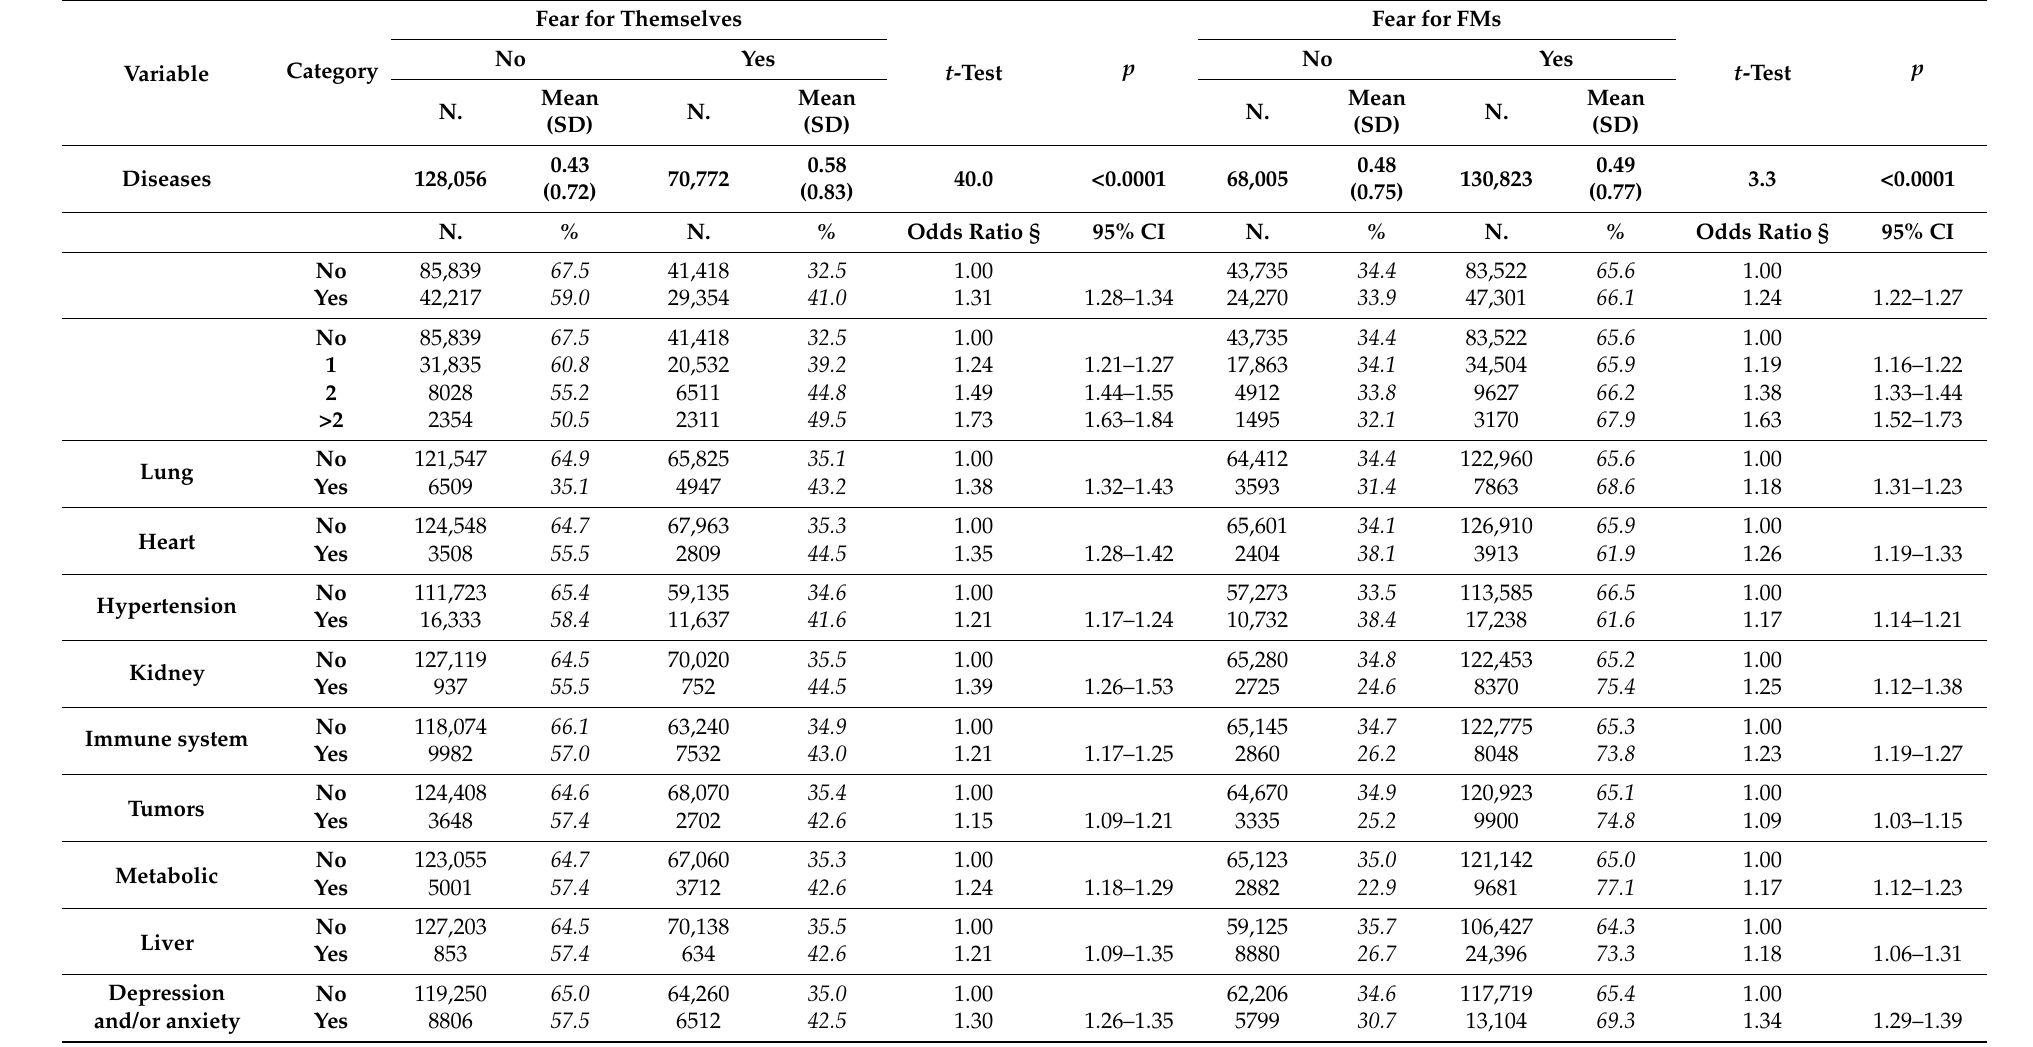
Table 3. Fear for themselves and for FMs according to chronic diseases by the EPICOVID19 survey